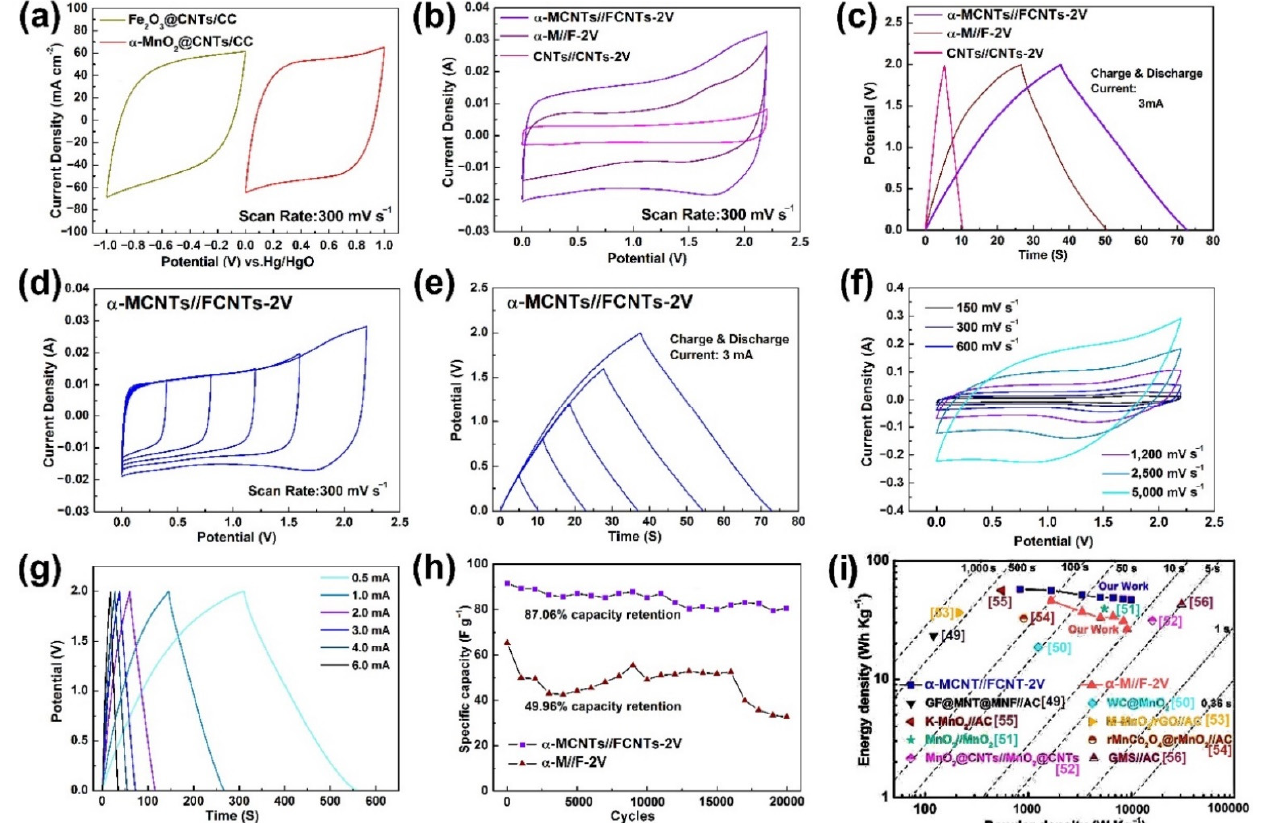
Figure 8. Properties of the α -MCNTs//FCNTs-2V supercapacitor in 1 M Na 2 SO 4 electrolyte: ( a ) CV plots of α -MnO 2 @CNTs/CC and Fe 2 O 3 @CNTs/CC at 300 mV s − 1 ; ( b ) CV plots and ( c ) GCD curves of α -MCNTs//FCNTs-2V, α -M//F-2V, and CNTs//CNTs-2V; Electrochemical properties of α -MCNTs//FCNTs-2V: ( d ) CV curves and ( e ) GCD curves of α -MCNTs//FCNTs-2V for different upper cut-off voltages, ( f ) CV curves, ( g ) GCD curves, ( h ) 20,000 cycles GCD test, and ( i ) Ragone plots showing the energy and power densities of the materials.